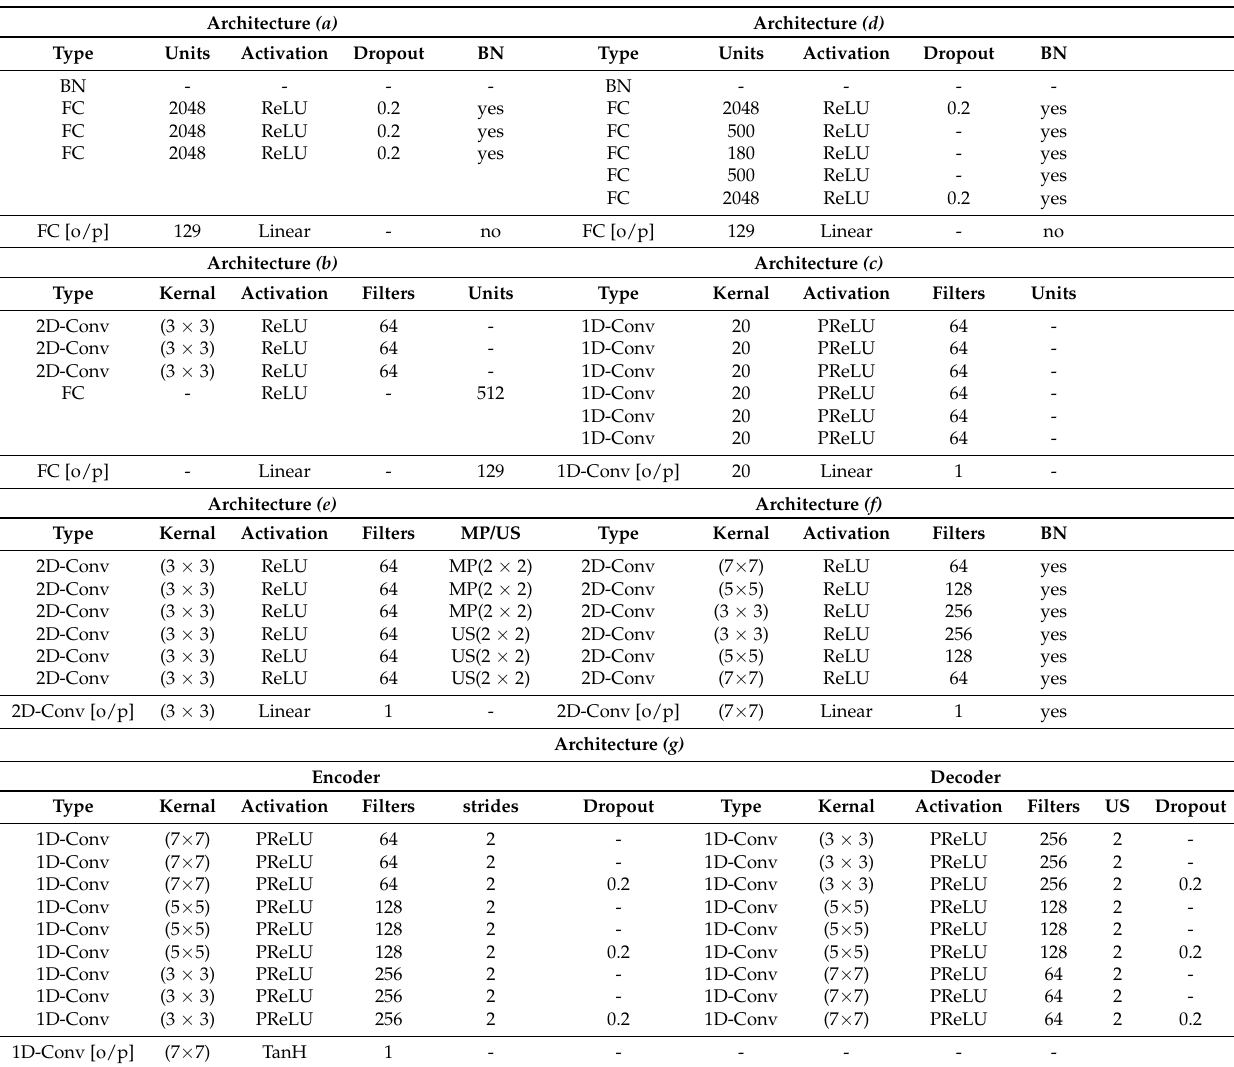
category is the FCNN [43], as in Figure 2c, with six 1D convolution layers with PReLU activations, and a final convolution output layer with linear activations. The used filter size was 64 and the kernel size was 20, and they are constant across all layers. Table 1. The configuration of the seven implemented DNNs. This table represents the different types of layers used: Batch Normalization (BN), Fully Connected (FC), and Convolution (Conv). It also represents the number of units (Units), activation function (Activation), dropout ratio (Dropout), kernel size (Kernel), number of filters (Filters), and the sizes of max pooling (MP), upsampling (US), and